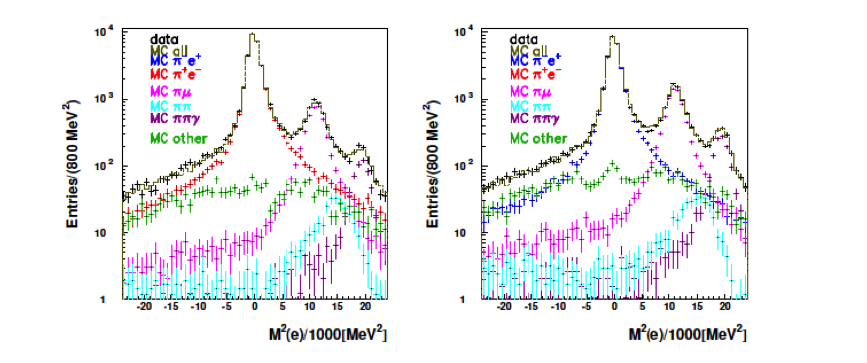
Figure 4. Lepton mass squared (in the electron / positron hypothesis) for the two di ff erent charges in semileptonic K S decays.